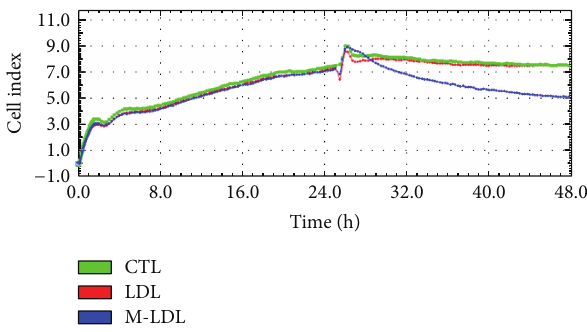
Figure 1: Dynamic real-time monitoring of HUVEC behavior using the xCELLigence RTCA system. Impedance Cell indexes (CIs) of HUVECs were monitored during 48 hours. Cells were seeded and incubated for 25 hours after which the medium was supplemented with native LDL, Mox-LDL, or mock medium. The result shown is representative of three independent experiments performed in